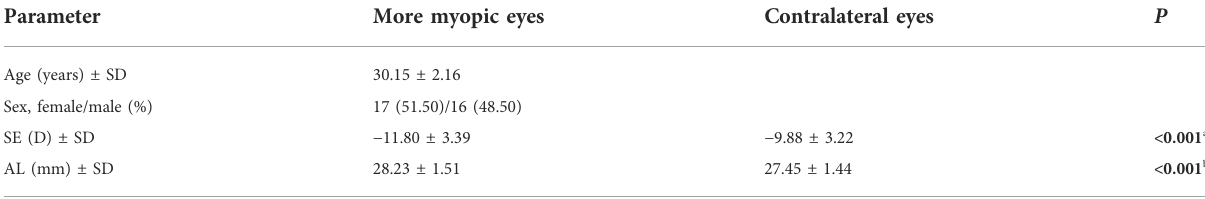
TABLE 1 Demographic and clinical characteristics of participants with highly myopic anisometropia Parameter More myopic